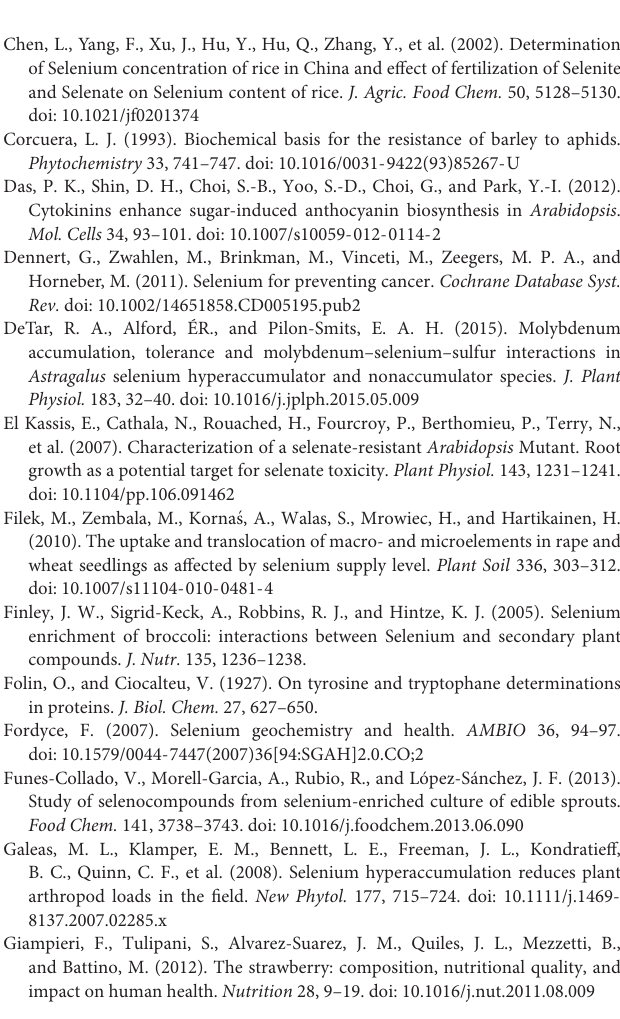
FIGURE S1 | SPAD index values of leaves measured in control, Se 10 and Se 100 µ M strawberry plants at the end of the production period; error bars indicate the standard error (SE), ( n = 6). TABLE S1 | Skin color parameters (L ∗ , a ∗ and b ∗ ) evaluated for strawberry fruits grown either in complete nutrient solution (control), either in nutrient solution supplied with 10 µ M Se or in nutrient solution supplied with 100 µ M